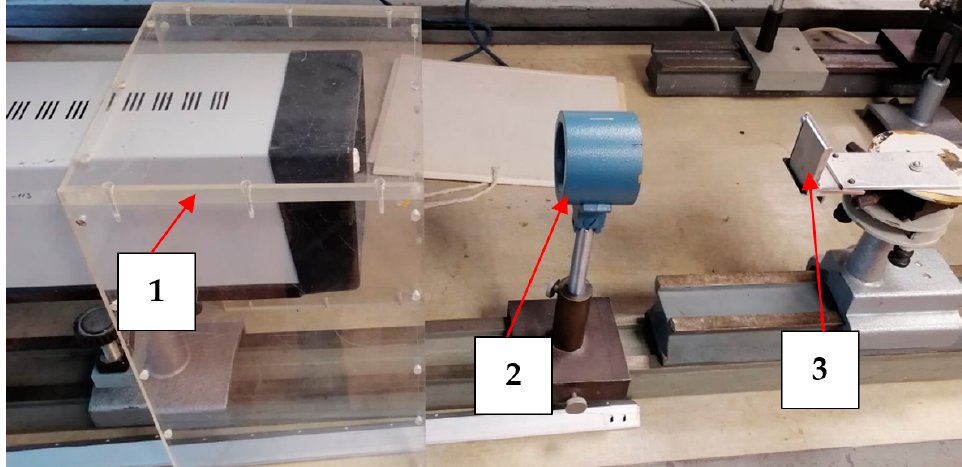
Figure 1. Photo of the optical layout of the Nd:YAG laser experimental setup: ( 1 ) Nd:YAG laser with a wavelength of 1064 µm, ( 2 ) focusing lens, and ( 3 ) sample surface. The laser focuses a 1064 µm beam onto the steel sample.